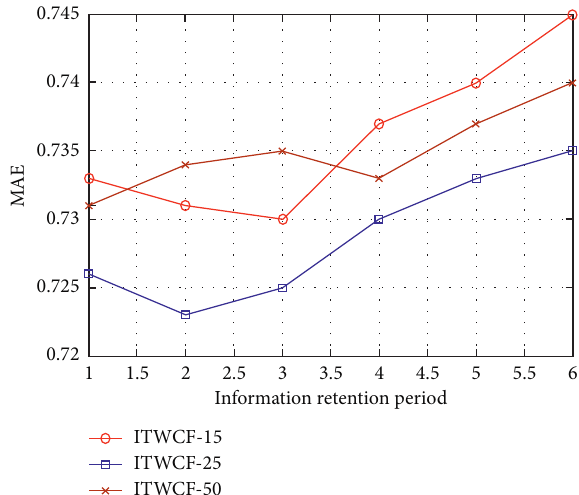
Figure 4: Performance comparison of five algorithms under dif- ferent nearest